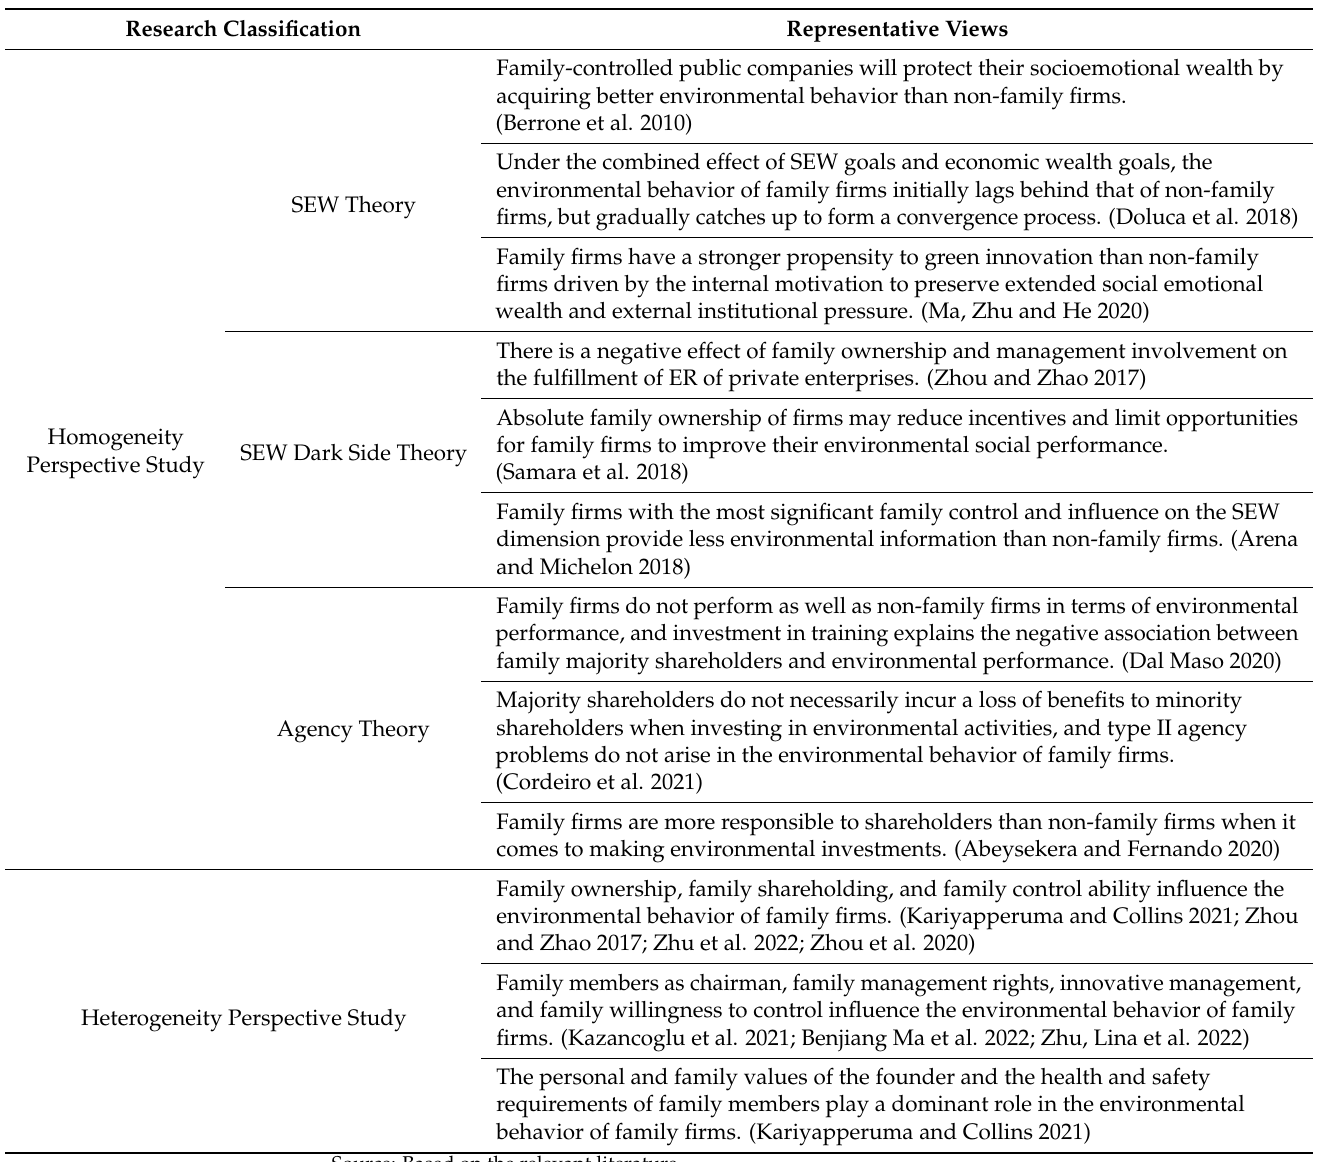
Table 2. The lineage of research on the factors influencing the environmental behavior of family